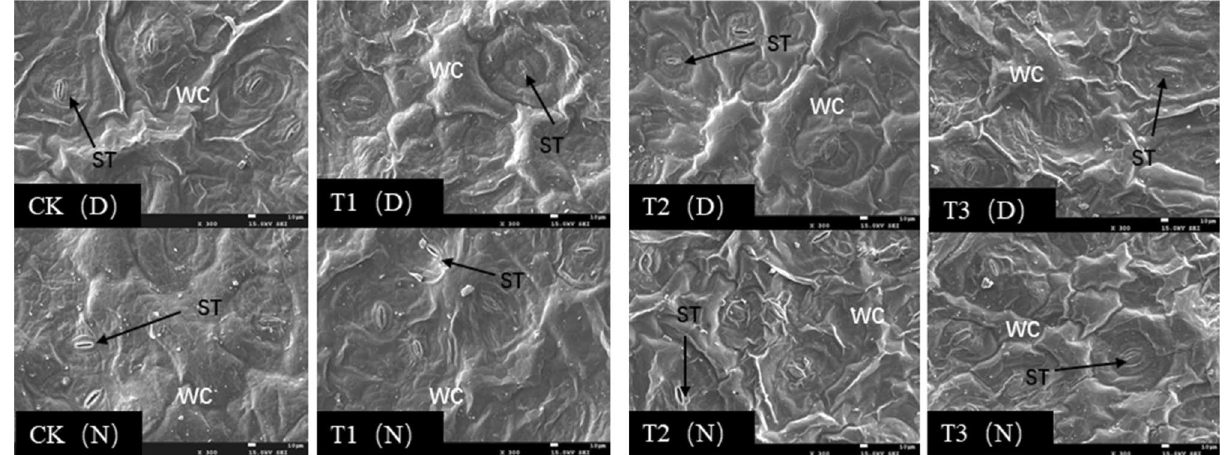
Figure 8. Scanning electron micrographs of Phedimus aizoon L. leaves under drought stress (× 300).